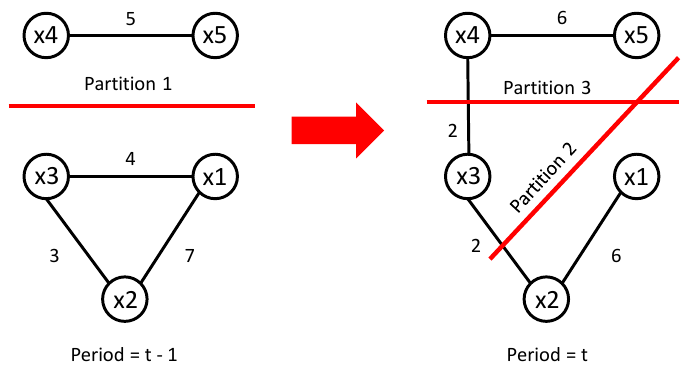
Figure 6. Two graphs at time periods t − 1 and t